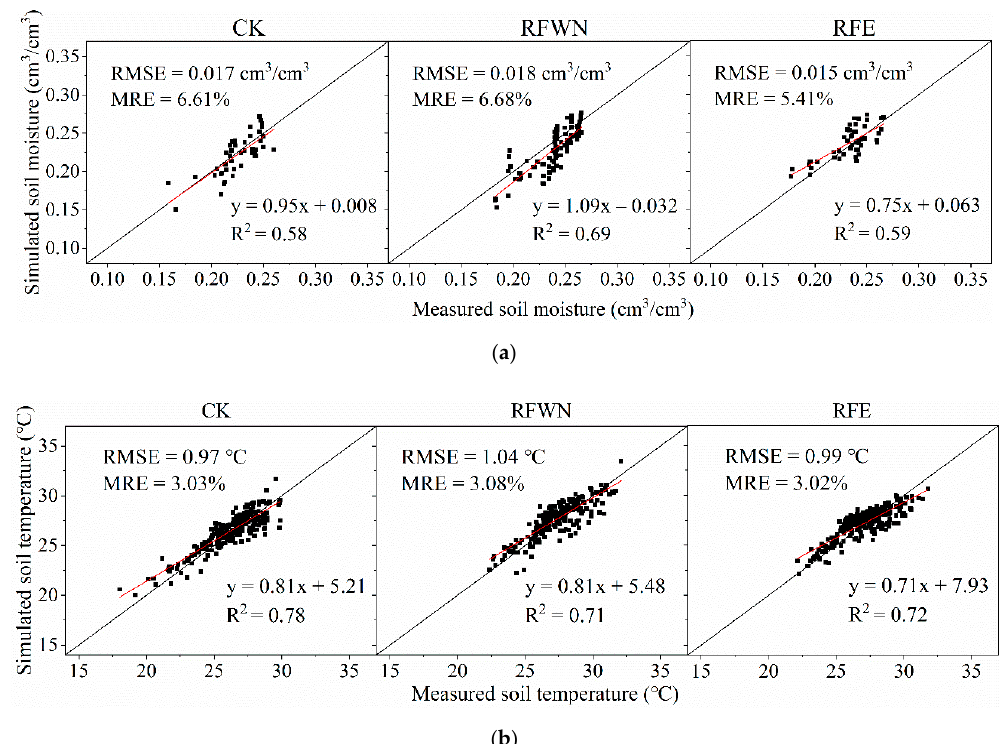
Figure 4. Validation results of soil moisture and temperature based on HYDRUS-2D model in 2018. ( a ) Validation results of soil moisture; ( b ) Validation results of soil